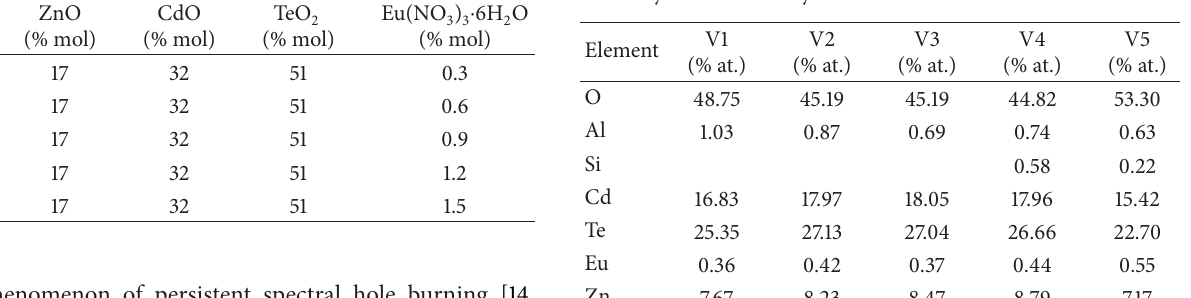
Table 1: Original batch composition for ZnO-CdO-TeO